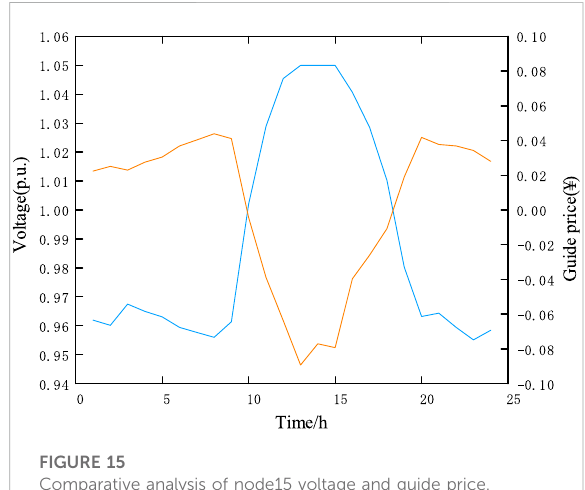
FIGURE 15 Comparative analysis of node15 voltage and guide price.